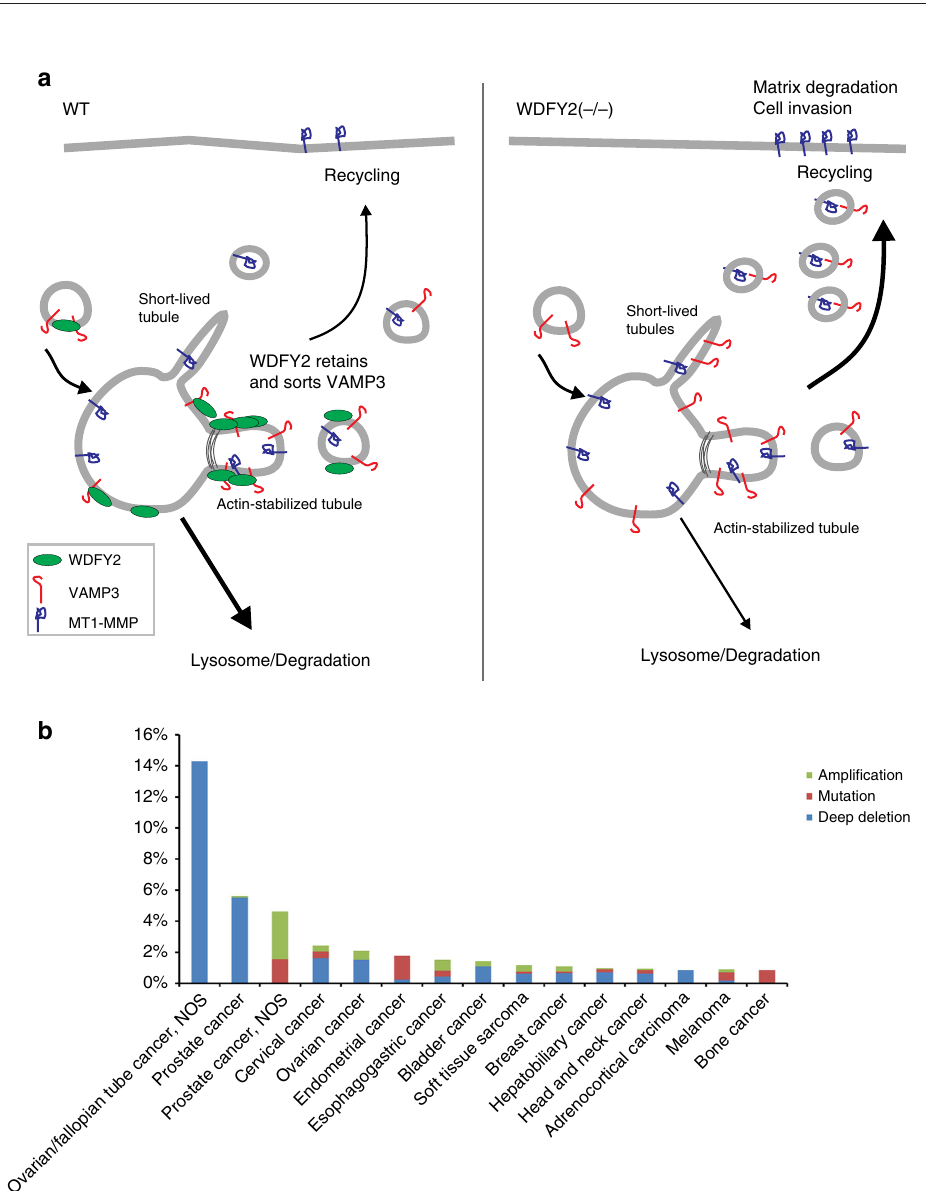
Fig. 10 WDFY2 controls cancer cell invasion. a Model of WDFY2 action in the endocytic system. In WT cells, WDFY2 interacts with VAMP3 and prevents sorting into bulk recycling tubules. This limits the amounts of VAMP3-positive recycling vesicles transporting MT1-MMP. In cells lacking WDFY2, more VAMP3 can be sorted into recycling vesicles, allowing more MT1-MMP to be recycled to the cell surface. b WDFY2 is frequently deep deleted in cancer samples. The graph shows data extracted from the CBioportal for Cancer Genomics, alteration frequency is grouped by cancer type and